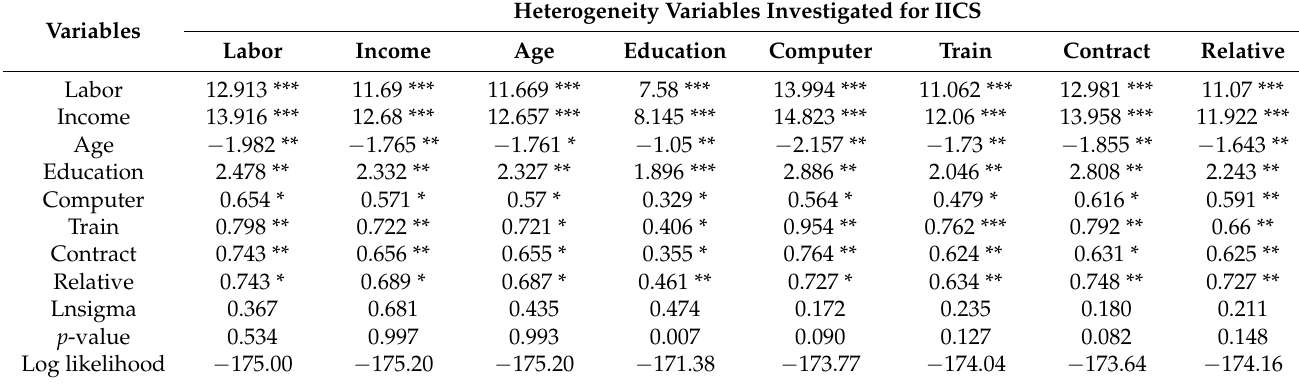
Table 8. Heterogeneity test and results for IICS.